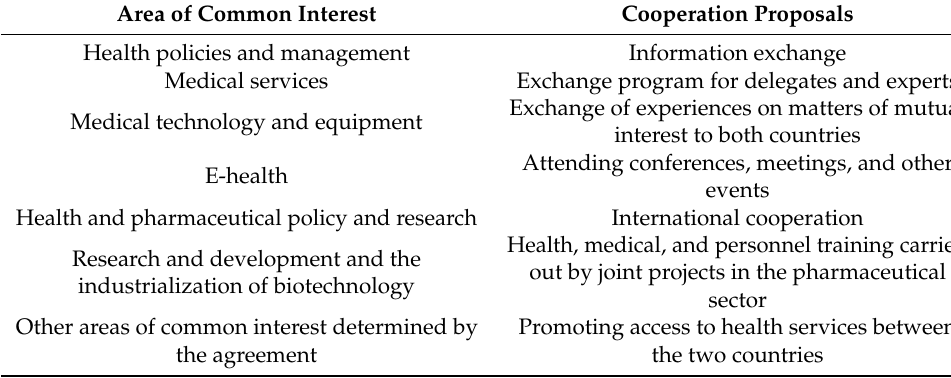
Table 6. Types of medical cooperation between South Korea and the